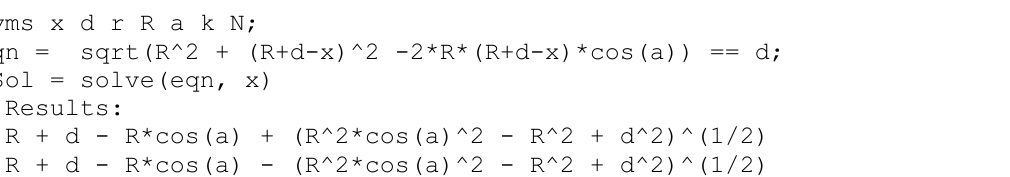
figure(5); hold on; grid on; title('d versus x')